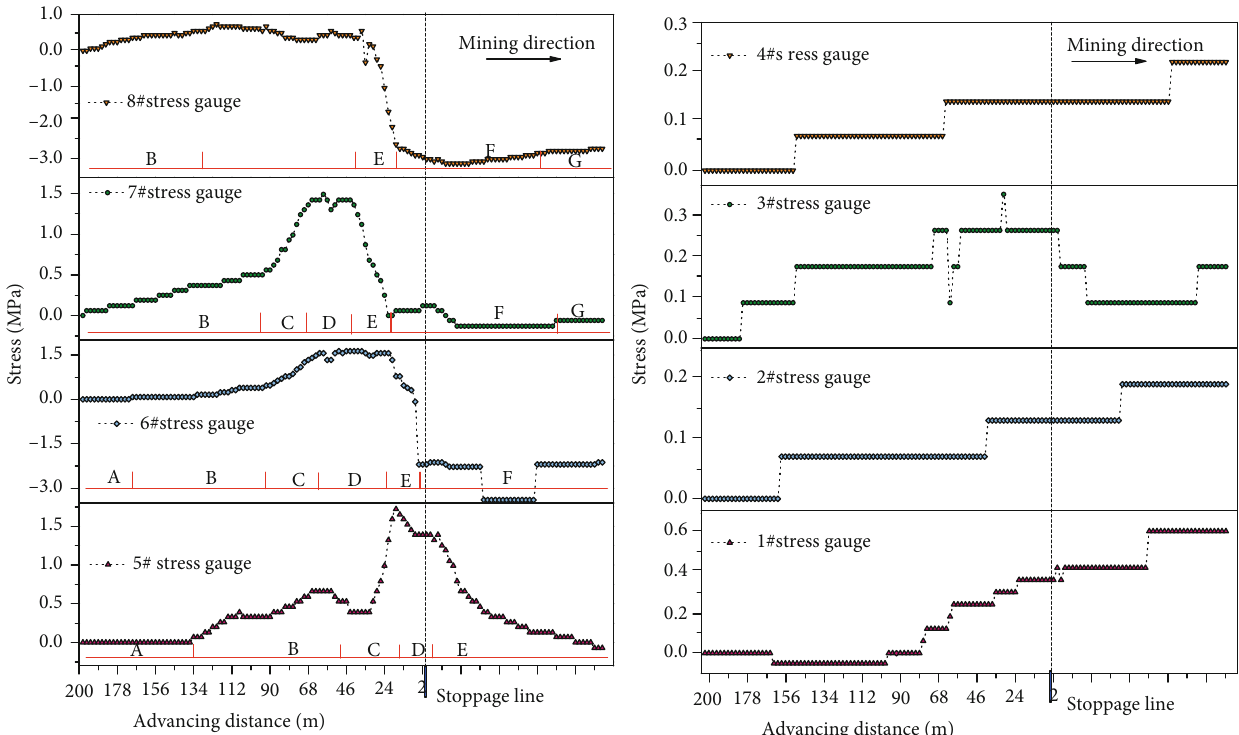
Figure 10: Stress evolution features on both sides of the stop line and working face